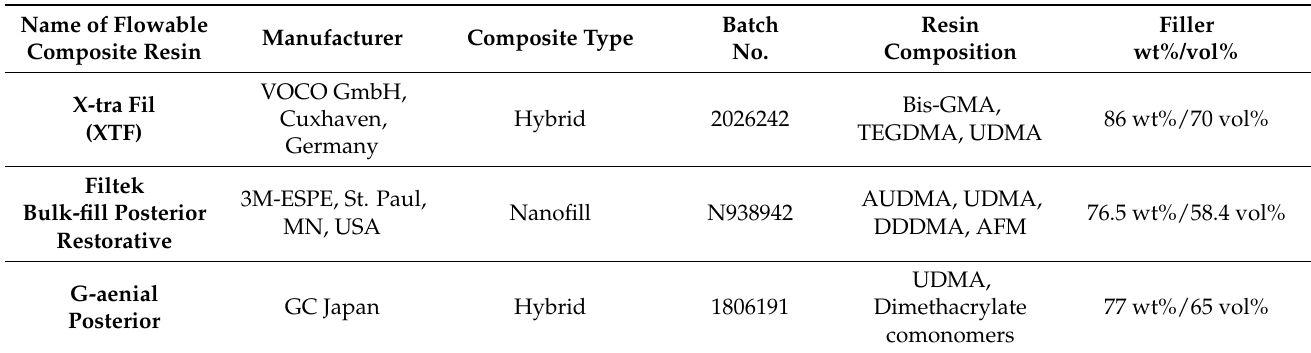
Table 1. Composition of the tested bulk-fill composite